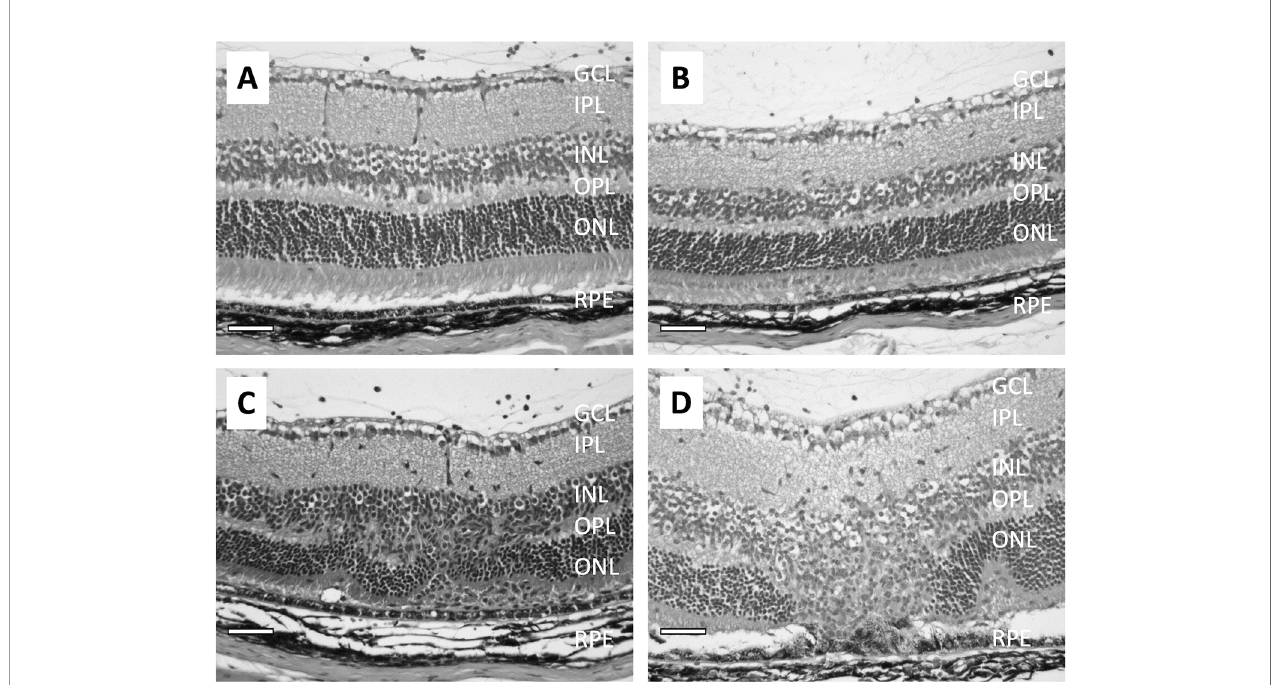
FIGURE 2 | Micrographs show the pathological changes of retina from mice with EAU clinical score ranging from 1 to 3. (A) shows a retina with EAU clinical score 1. The RPE is intact and there are no noted changes in the retina except for some in fl ammatory cells in the vitreous. (B) shows the retina with EAU clinical score 2. There are more in fi ltrating cells in the vitreous and the subretinal space. Both the retina and RPE are intact, with minor lesions found in the INL. (C) is the retina at early stage of chronic EAU, clinical score 3. The RPE is intact, and in fi ltration of in fl ammatory cells are found in the vitreous and in the retina with disruption of the INL and IPL with loss of the ONL cells. (D) shows the retina at a late stage of chronic EAU, sustained clinical score of 3. The RPE monolayer is disrupted and fused with the ONL and adjacent outer/inner segments of the photoreceptors gone. There are pigment- fi lled macrophages around sites of RPE cell loss. The size bar is 50 microns in